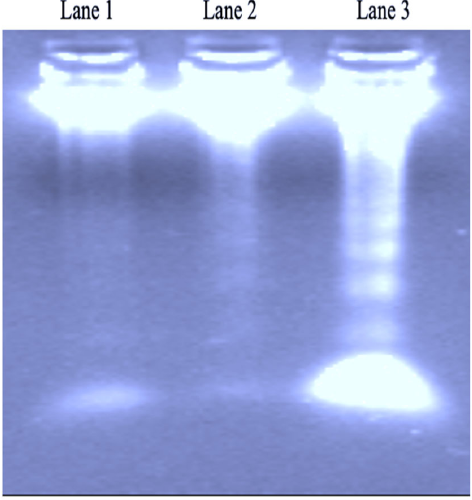
Figure 3. Analysis of DNA fragmentation of P. roxburghii and N. graveolens extracts against HCT-116 cells. Lane 1 untreated as a control; Lane 2 treated with P. roxburghi IC 50 = 30.6 µ g mL − 1 ; Lane 3 treated with N. graveolens IC 50 = 26.5 µ g mL − 1 .